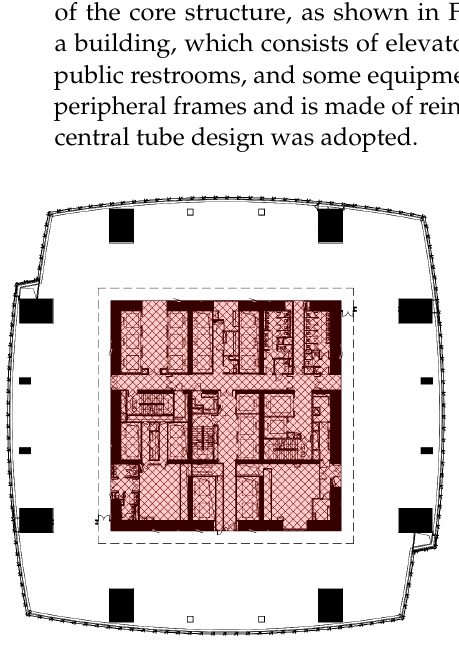
Figure 5. Legend of core area.